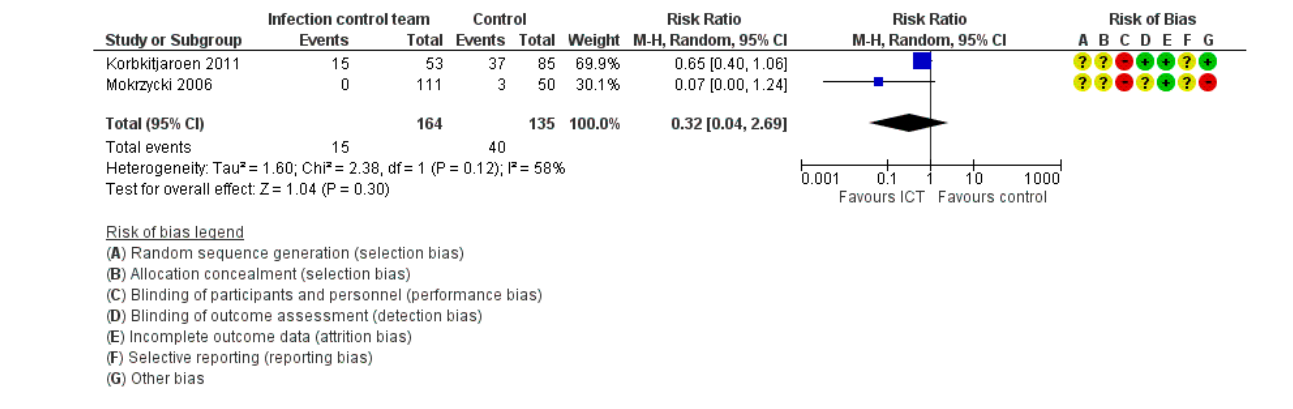
Figure 5. Meta-analysis for the death due to HCAIs [28,31].